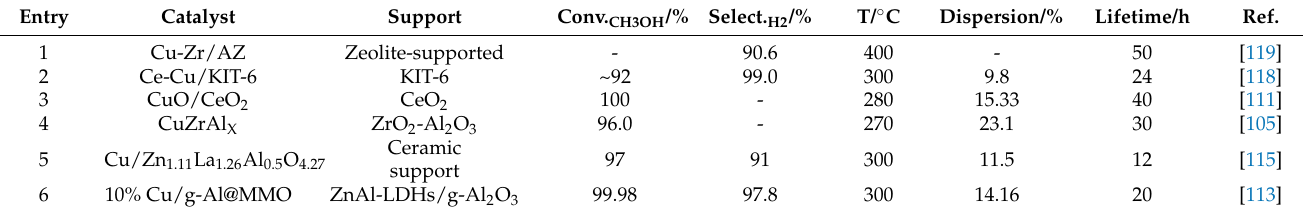
Table 3. Copper-based catalysts on different supports for